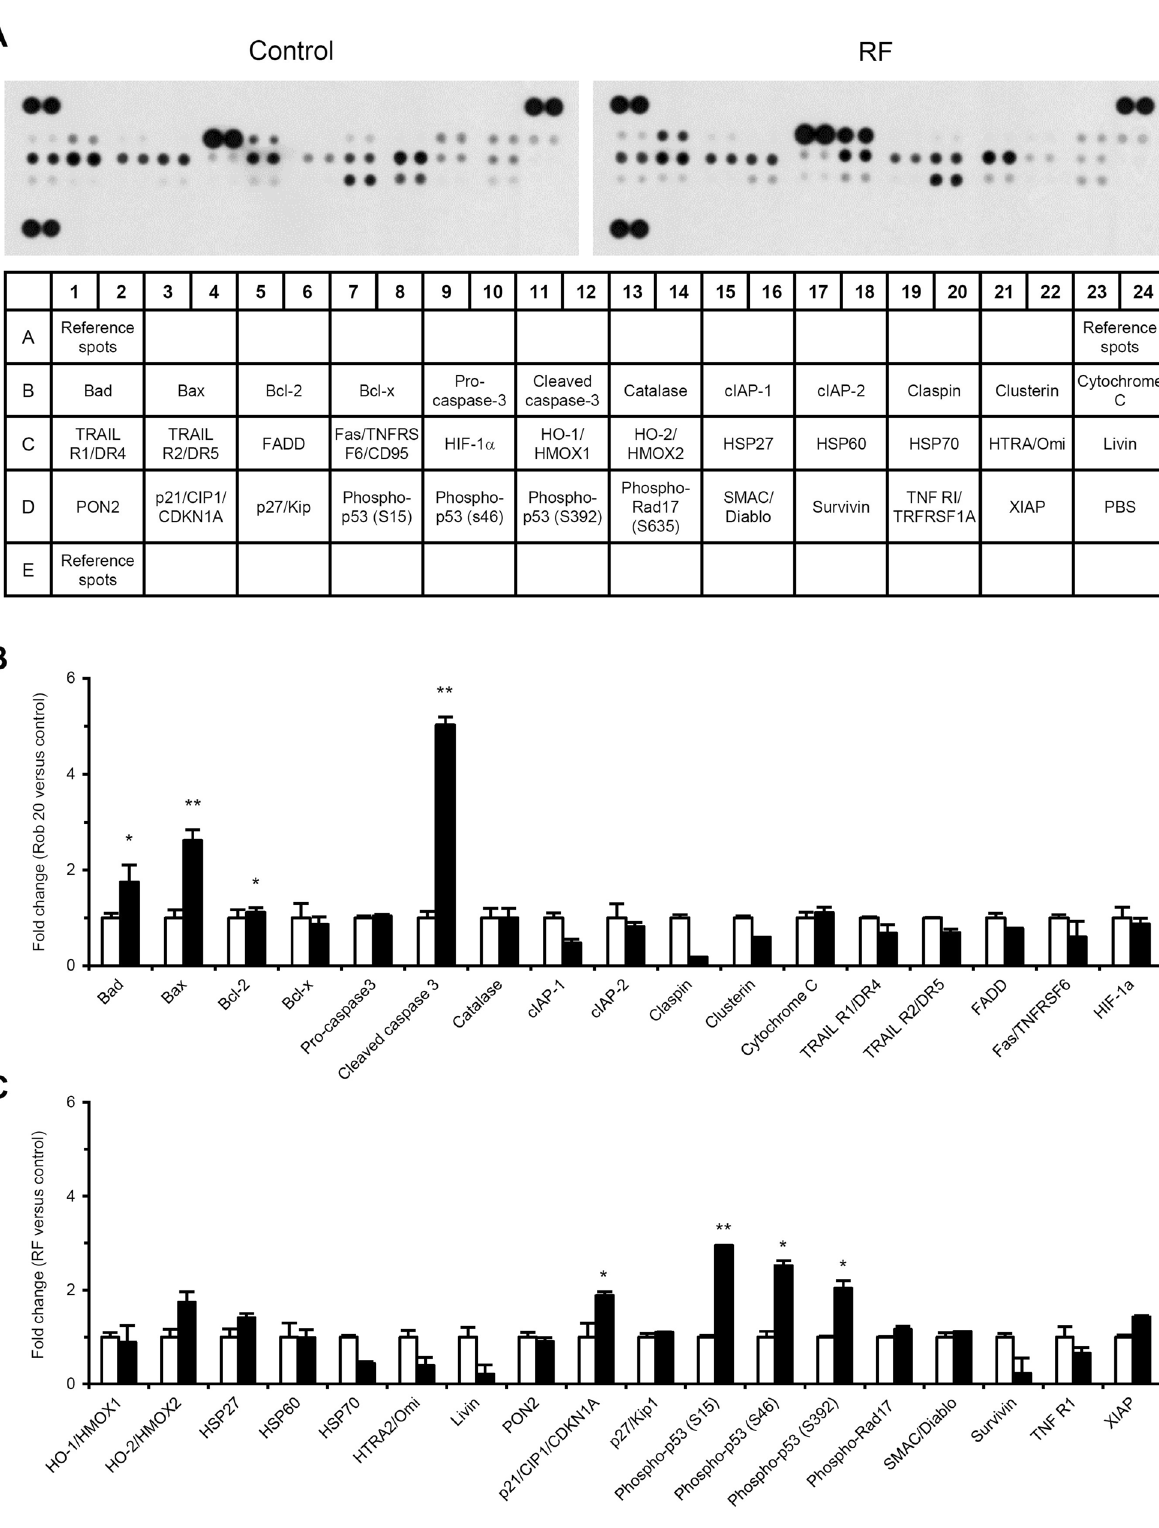
Figure 3. Effects of RF on apoptosis-related protein expression. ( A ) HUVECs were treated with 20 μM RF for 36 h, protein extracts were prepared, and apoptosis-associated protein-expression levels were determined. ( B , C ) Relative protein expression levels were estimated after quantifying the pixel densities in autoradiograms using ImageJ. Data from three independent experiments of ( A ) are presented as the mean ± SD; * p < 0.05, ** p < 0.01, compared to the